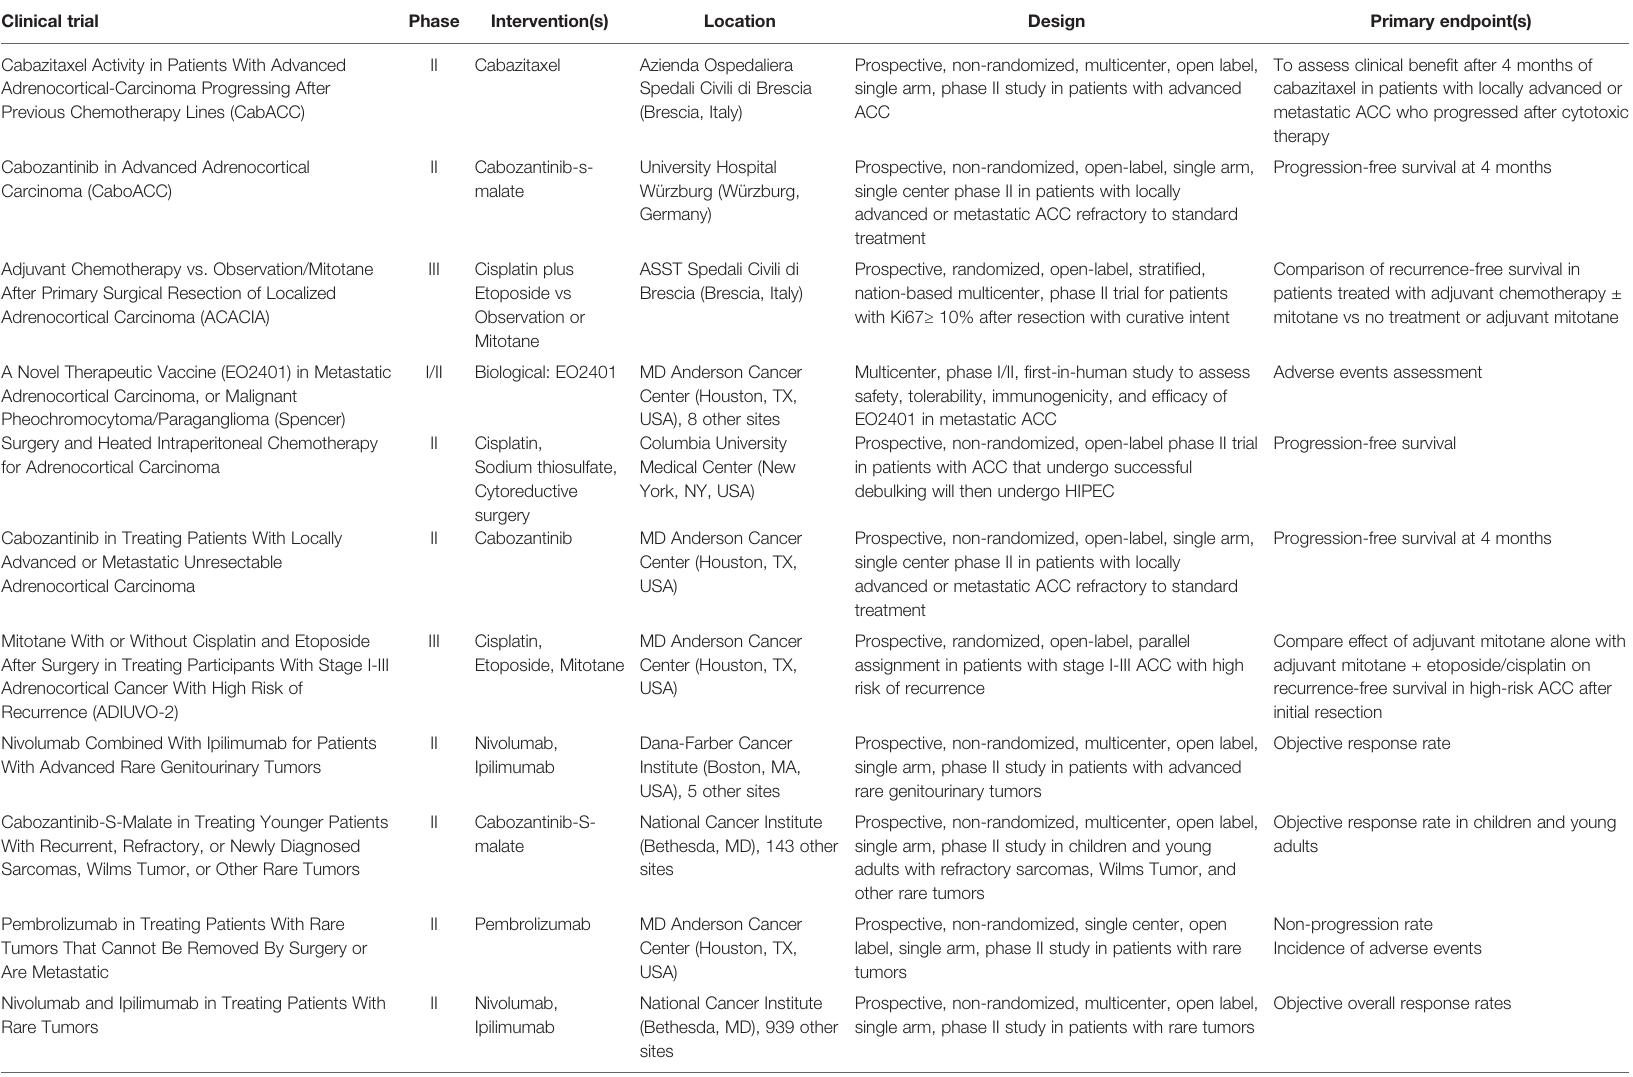
TABLE 1 | Clinical trials that are actively recruiting for adrenocortical